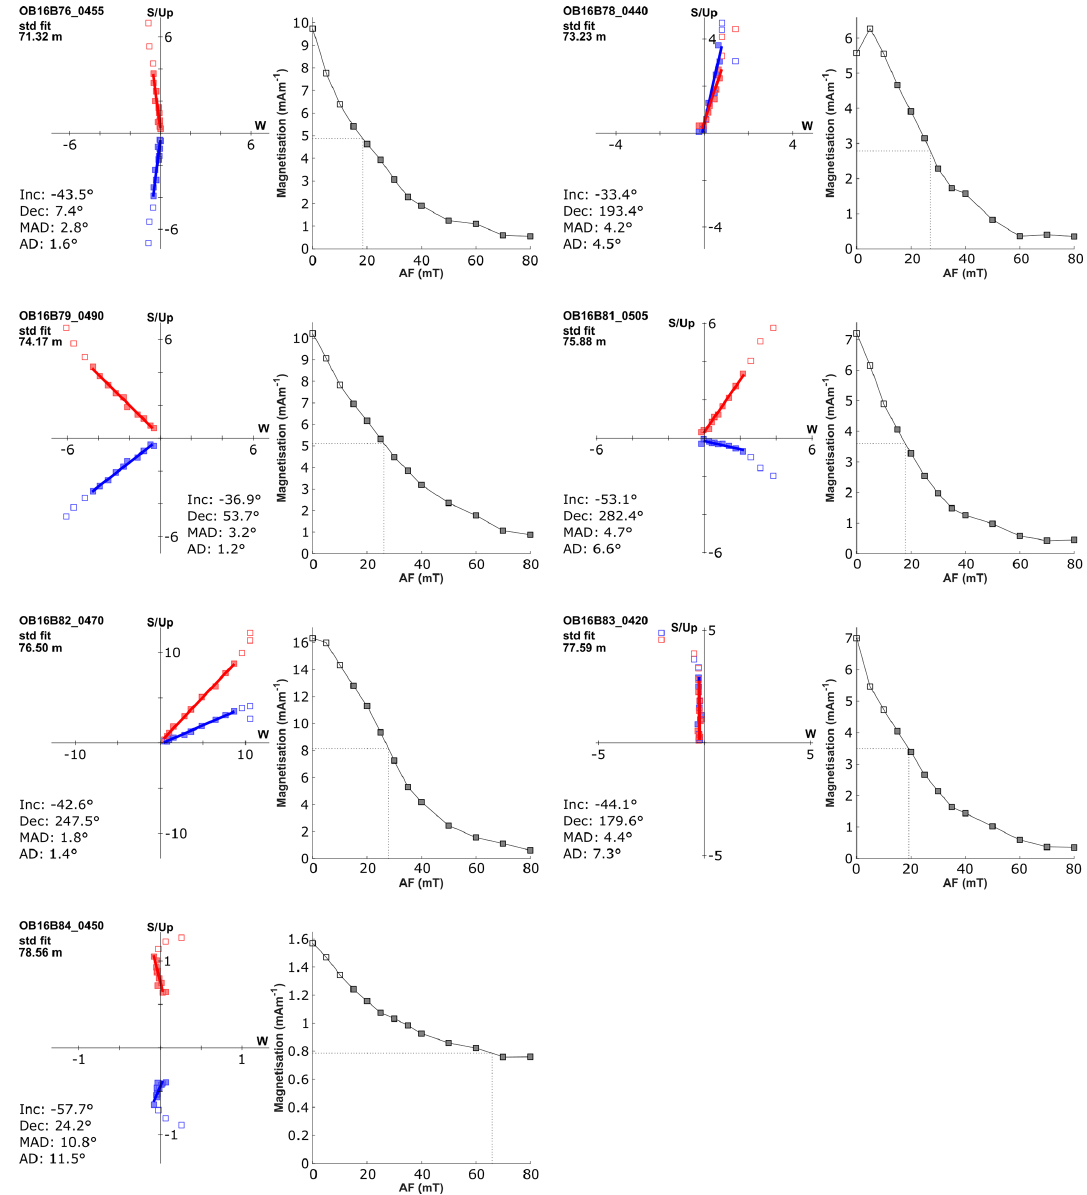
Figure C4. Orthogonal plots and intensity of magnetisation after stepwise demagnetisation of pilot samples